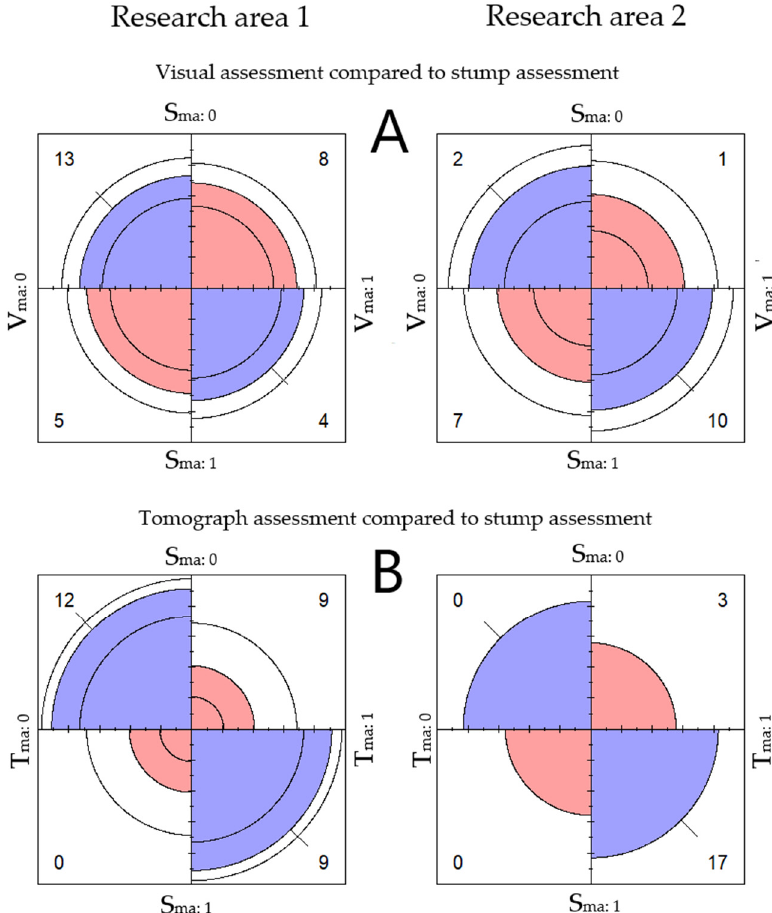
Figure 5. Comparison between the two research areas. ( A ) The relationship between major defect assessed visually V ma and major defect assessed from the tree stump S ma . ( B ) The relationship between major defect assessed with the tomograph T ma and major defect assessed from the tree stump S ma . The relationship between variables is indicated by the tendency of the diagonally located cells. Color is used to indicate direction